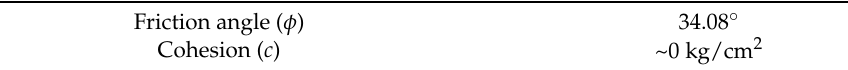
Figure 6. Shear and normal stress of sand. Table 2. Total parameters of sand.